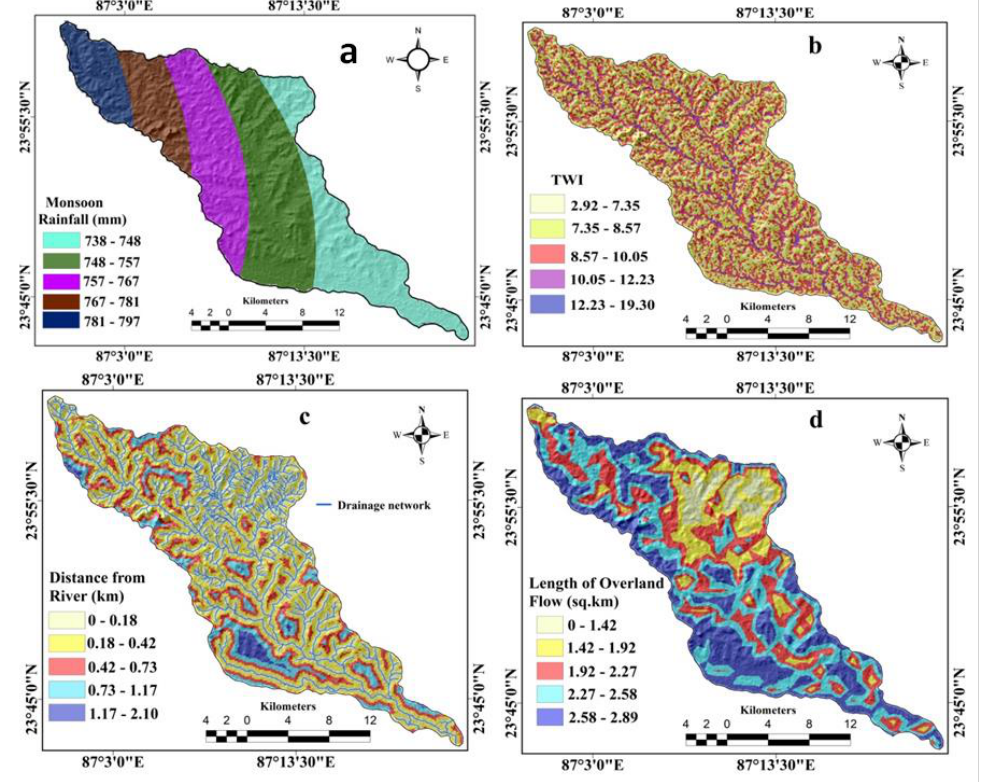
Figure 5. Hydrological factors: ( a ) monsoonal rainfall, ( b ) topographical wetness index (TWI), ( c ) distance to river, ( d ) length of overland flow (Lof).